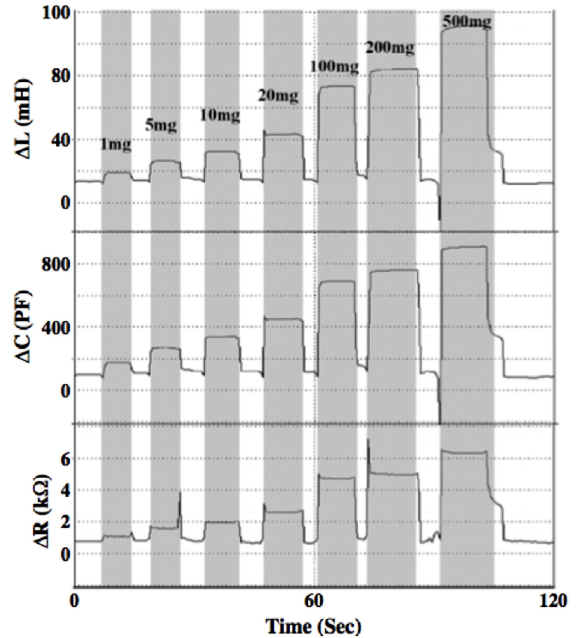
Figure 22. Changes of L , C and R parameters when different loads were applied to the 5 wt% CMC/polysilicone sensor with a 10 × 10 × 1 mm 3 size [7]. Reprinted with permission from [7], Copyright 2006 IOP